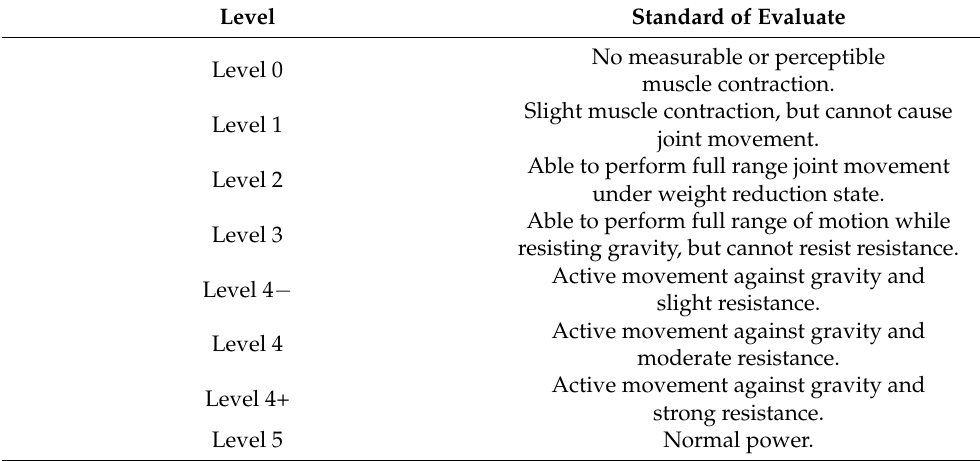
Table 1. MRC grading—MMT. Level Standard of Evaluate Level 3